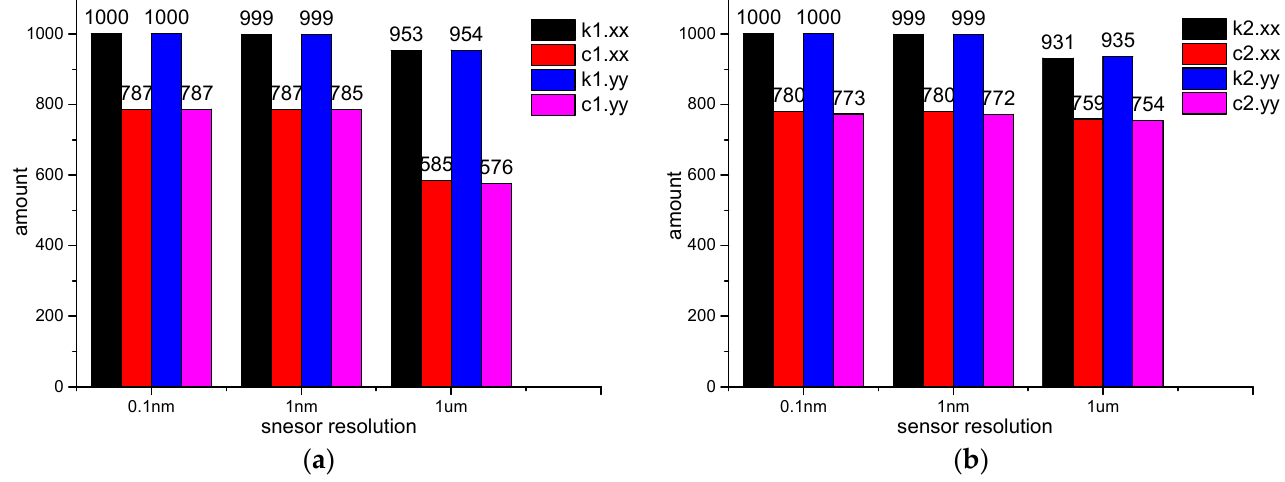
Figure A4. Statistical results of the amount of the frequencies, at which the related error is less than 10%: ( a ) #1 bearing; ( b ) #2 bearing.